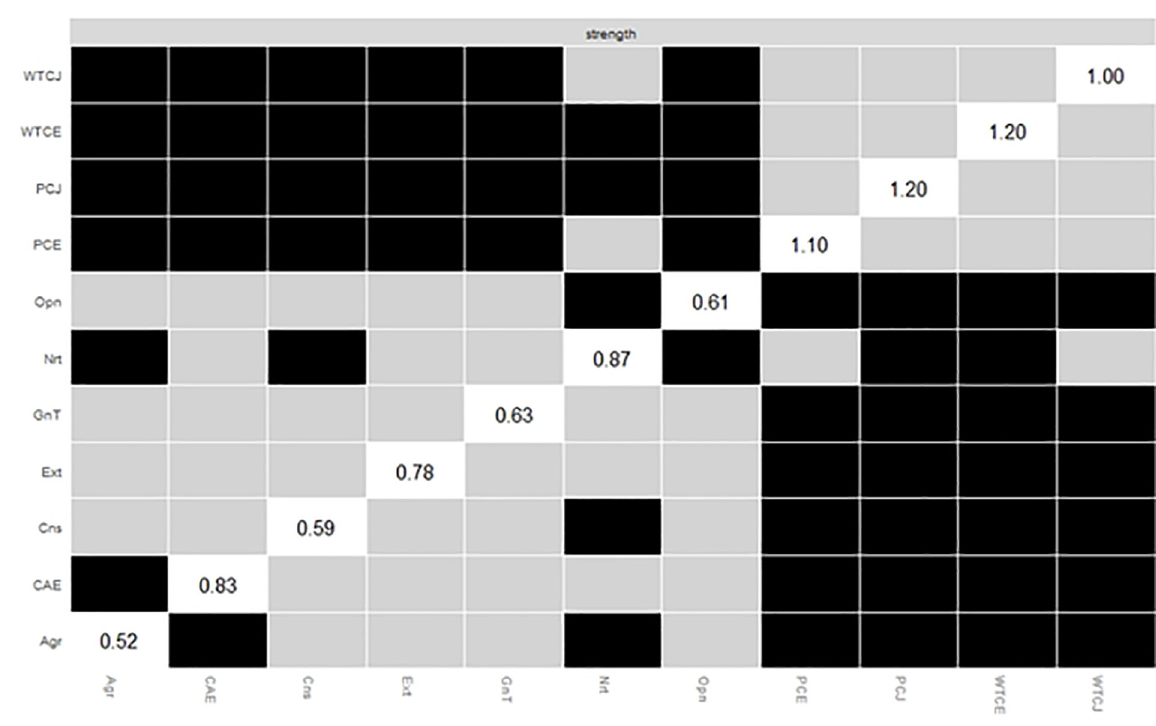
Fig 6. Bootstrapped differences ( α = 0.05) between the node strengths of the factors. Gray boxes indicate nodes that do not differ significantly from one another. Black boxes indicate nodes that differ significantly from one another. White boxes in the centrality plot show the value of the node strength. The abbreviations are the same as Fig